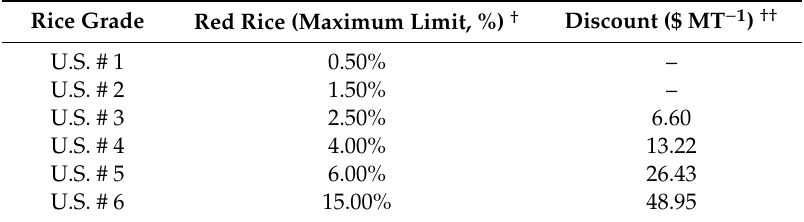
Table 1. Milled rice standards and dockage for presence of red